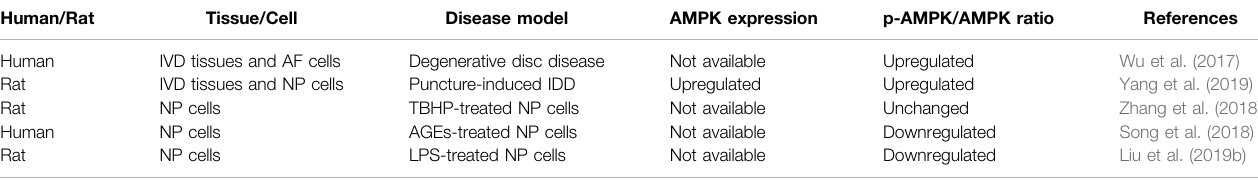
TABLE 1 | The expression and activity of AMPK in IDD.